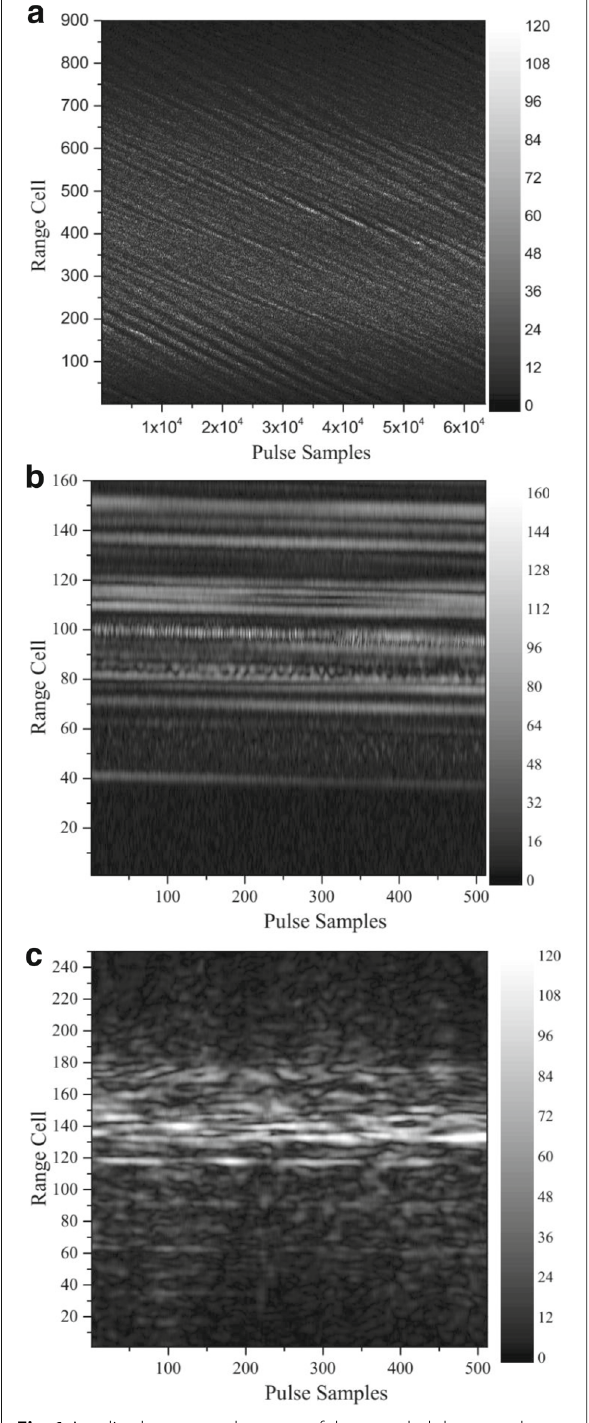
Fig. 1 Amplitude-range-pulse maps of the recorded data samples: a Sea clutter. b target 1. c target 2